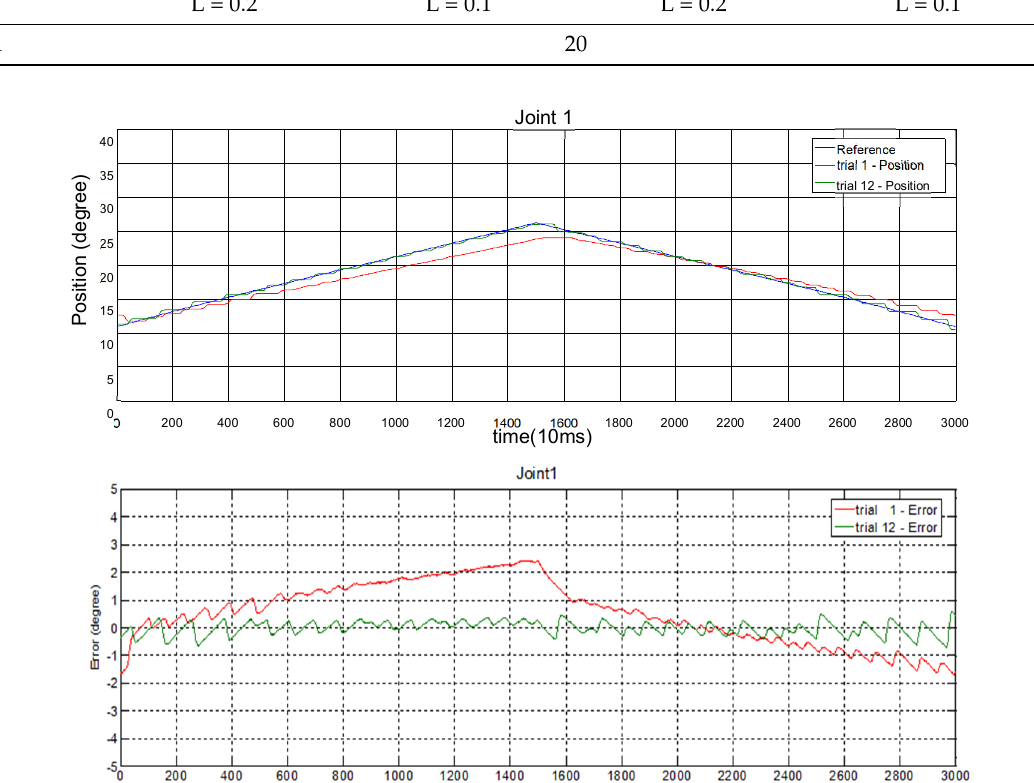
Figure 22. Schematic diagram of the robotic arm in the loading experiment.